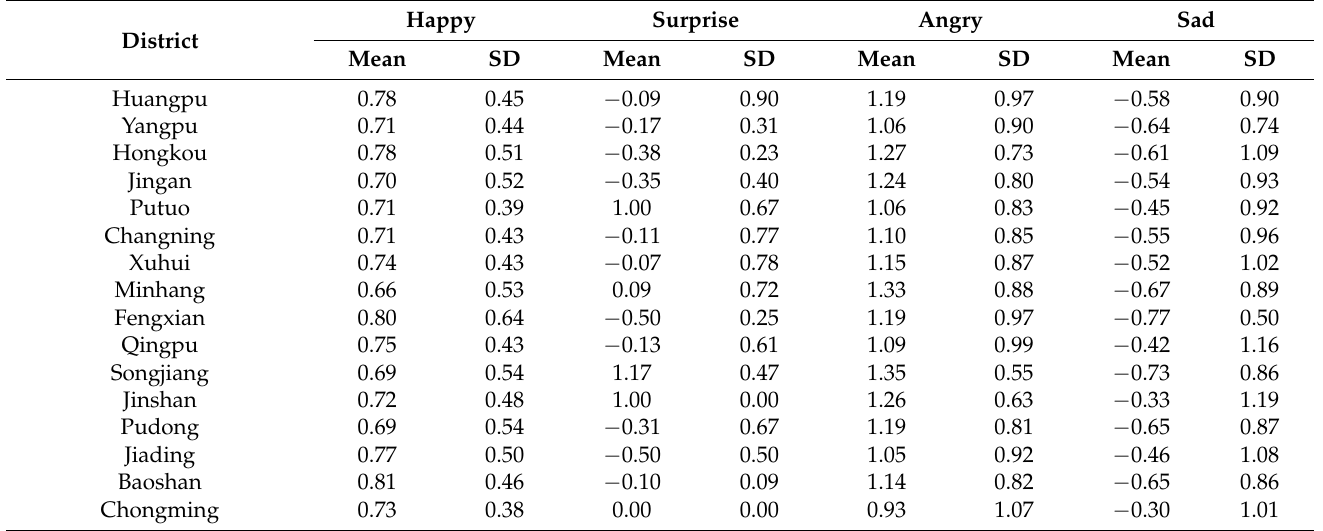
Table 5. Sentiment intensity.